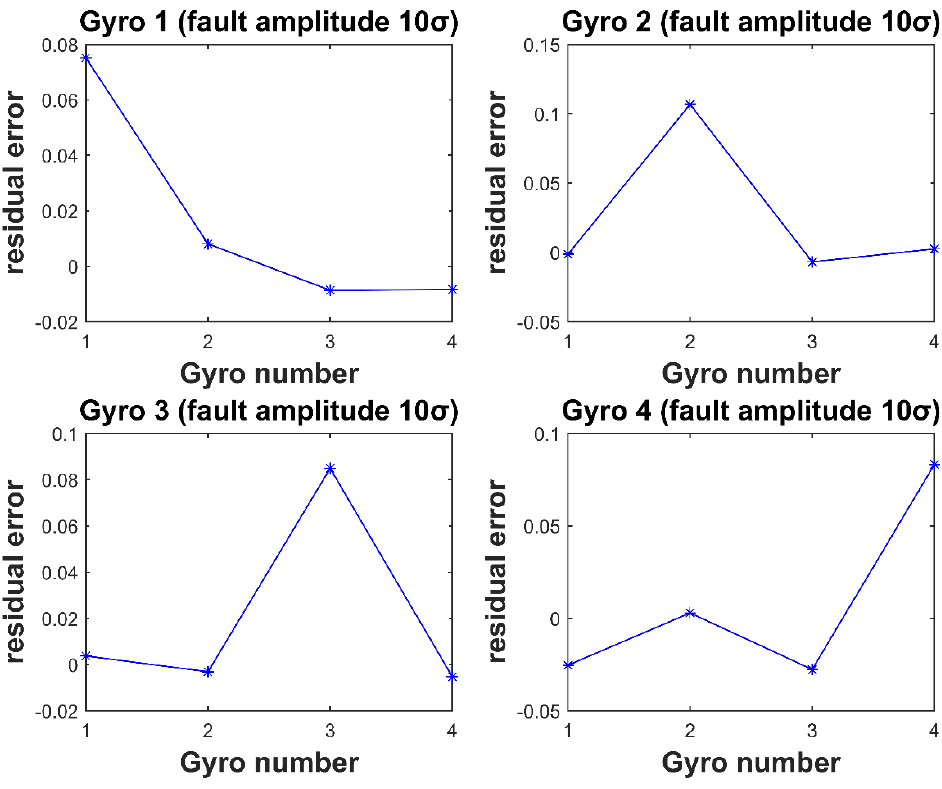
Figure 3. Residual vector values for Gyro 1–4 injection of